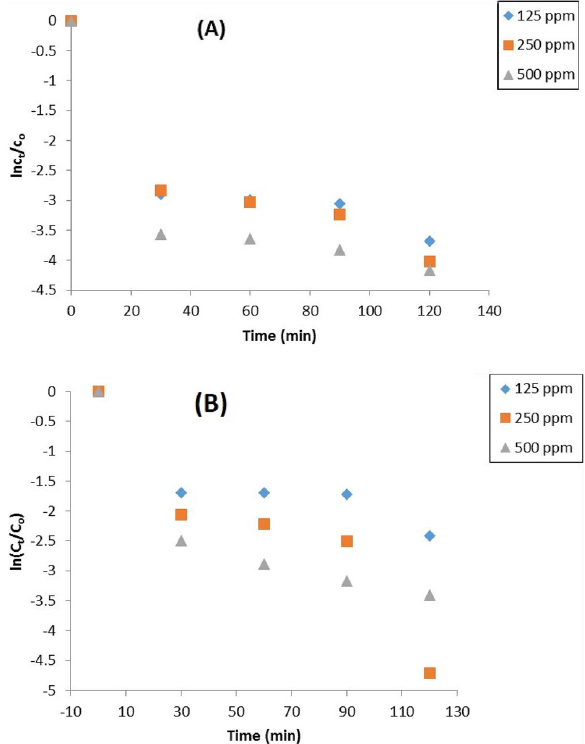
Figure 9. Kinetic study of photocatalytic degradation of oil spills using ( A ) MT18, ( B ) MT48.